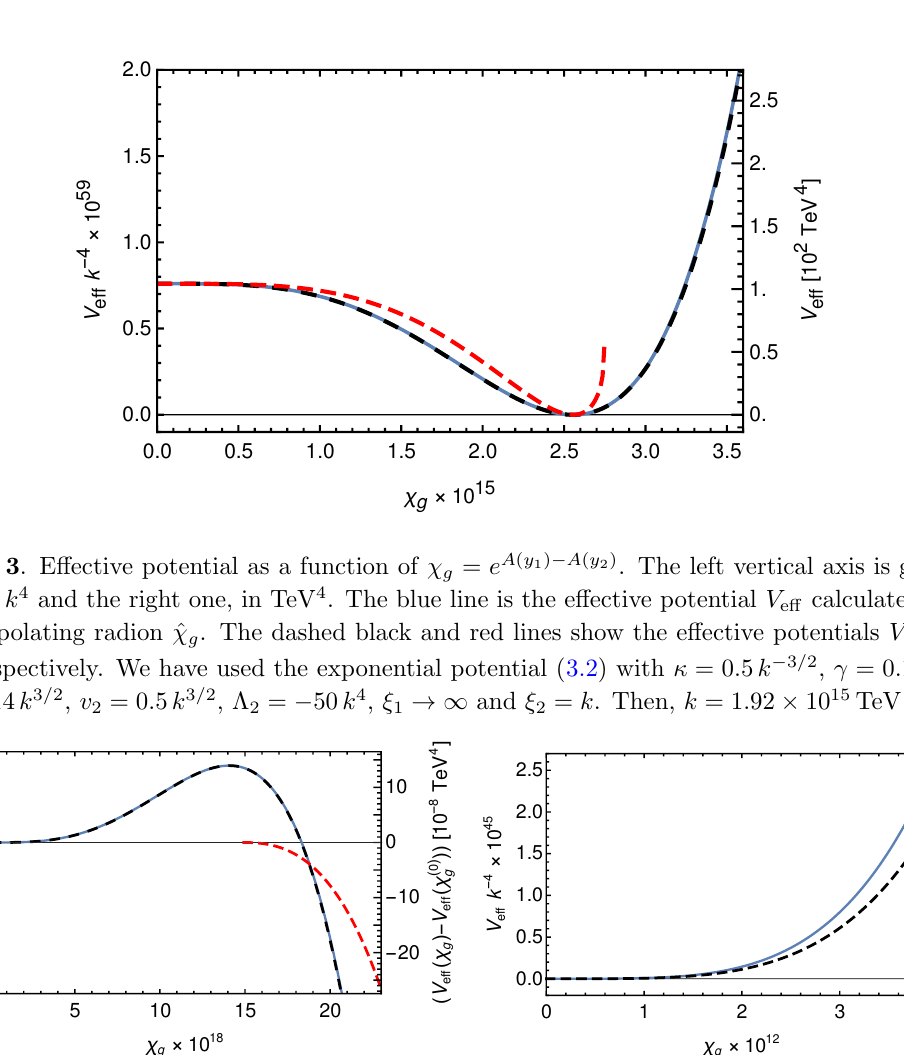
Figure 4 . E(cid:11)ective potential as a function of (cid:31) g = e A ( y 1 ) (cid:0) A ( y 2 ) . On the left the e(cid:11)ective potentials are normalized to vanish in the lowest reachable value for (cid:31) g , (cid:31) (0) g . The blue line is the e(cid:11)ective potential V e(cid:11) calculated using as interpolating radion ^ (cid:31) g . The dashed black and red lines show the e(cid:11)ective potentials V ( y ) and V ( (cid:30) ) respectively. On the left, (cid:31) g takes values (cid:24) 10 (cid:0) 17 , and on e(cid:11) e(cid:11) the right, (cid:31) g (cid:24) 10 (cid:0) 12 . We have used the same bulk potential as in (cid:12)gure 3: the exponential potential (3.2) with (cid:20) = 0 : 5 k (cid:0) 3 = 2 , (cid:13) = 0 : 1 k (cid:0) 3 = 2 , v 1 = (cid:0) 14 k 3 = 2 , v 2 = 0 : 5 k 3 = 2 , (cid:3) 2 = (cid:0) 50 k 4